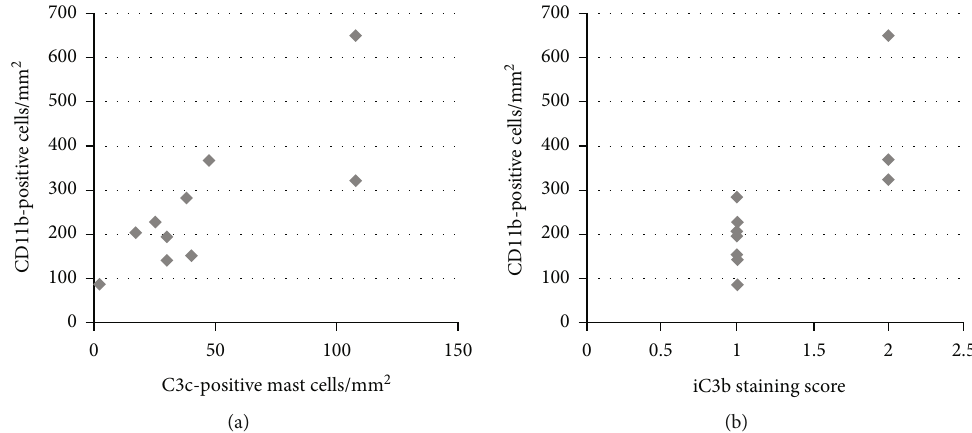
Figure 2: The correlation of (a) the number of C3c-positive mast cells ( r = 0 : 726 , p = 0 : 018 ) or (b) the staining score of iC3b ( r = 0 : 798 , p = 0 : 006 ) to the number of CD11b-positive cells in the nonlesional skin of 10 patients with